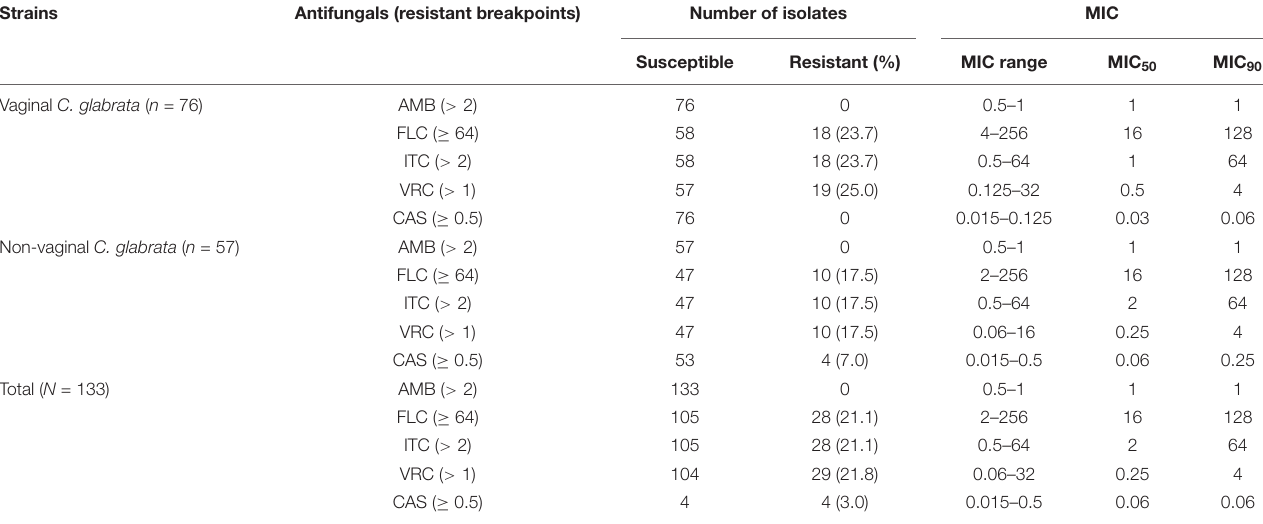
TABLE 2 | Summary of in vitro antifungal susceptibilities of 76 vaginal C. glabrata and 57 non-vaginal C. glabrata isolates by broth microdilution method. Strains